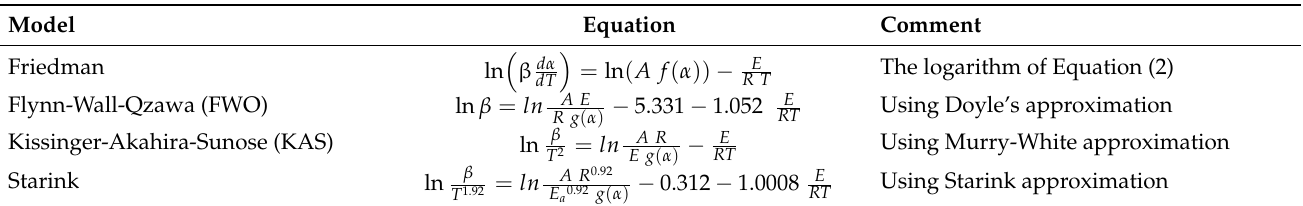
Table 4. Isoconversional models (Mortezaeikia et al. (2021) [4], Mumbach et al. (2019) [20]). Model Equation